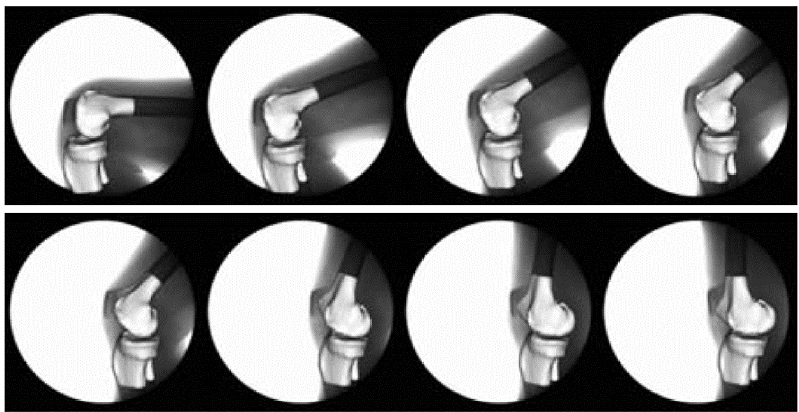
Figure 4. Example of 3D knee templates re-projected into the fluoroscopic image